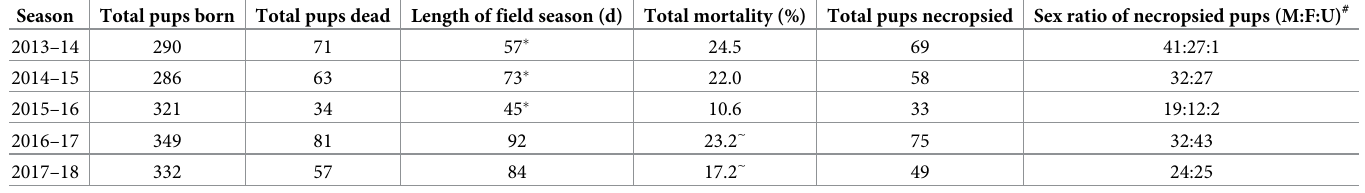
Table 1. Summary of New Zealand sea lion ( Phocarctos hookeri ) pup births and deaths at Sandy Bay, Enderby Island from 2013–14 to 2017–18. Total pups born was determined by a direct count [3]. Season